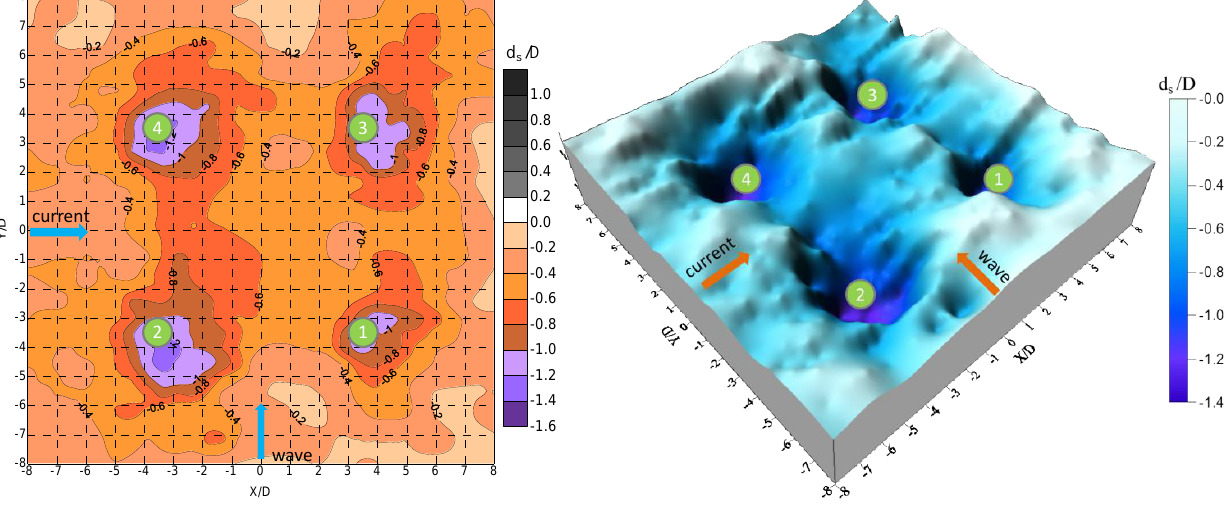
Figure 4. The 2 D and 3 D potential impact erosion area and scouring around the four piles with the jacket-type foundation under the case, 12TLLCM (80 min, i.e. , after finishing the